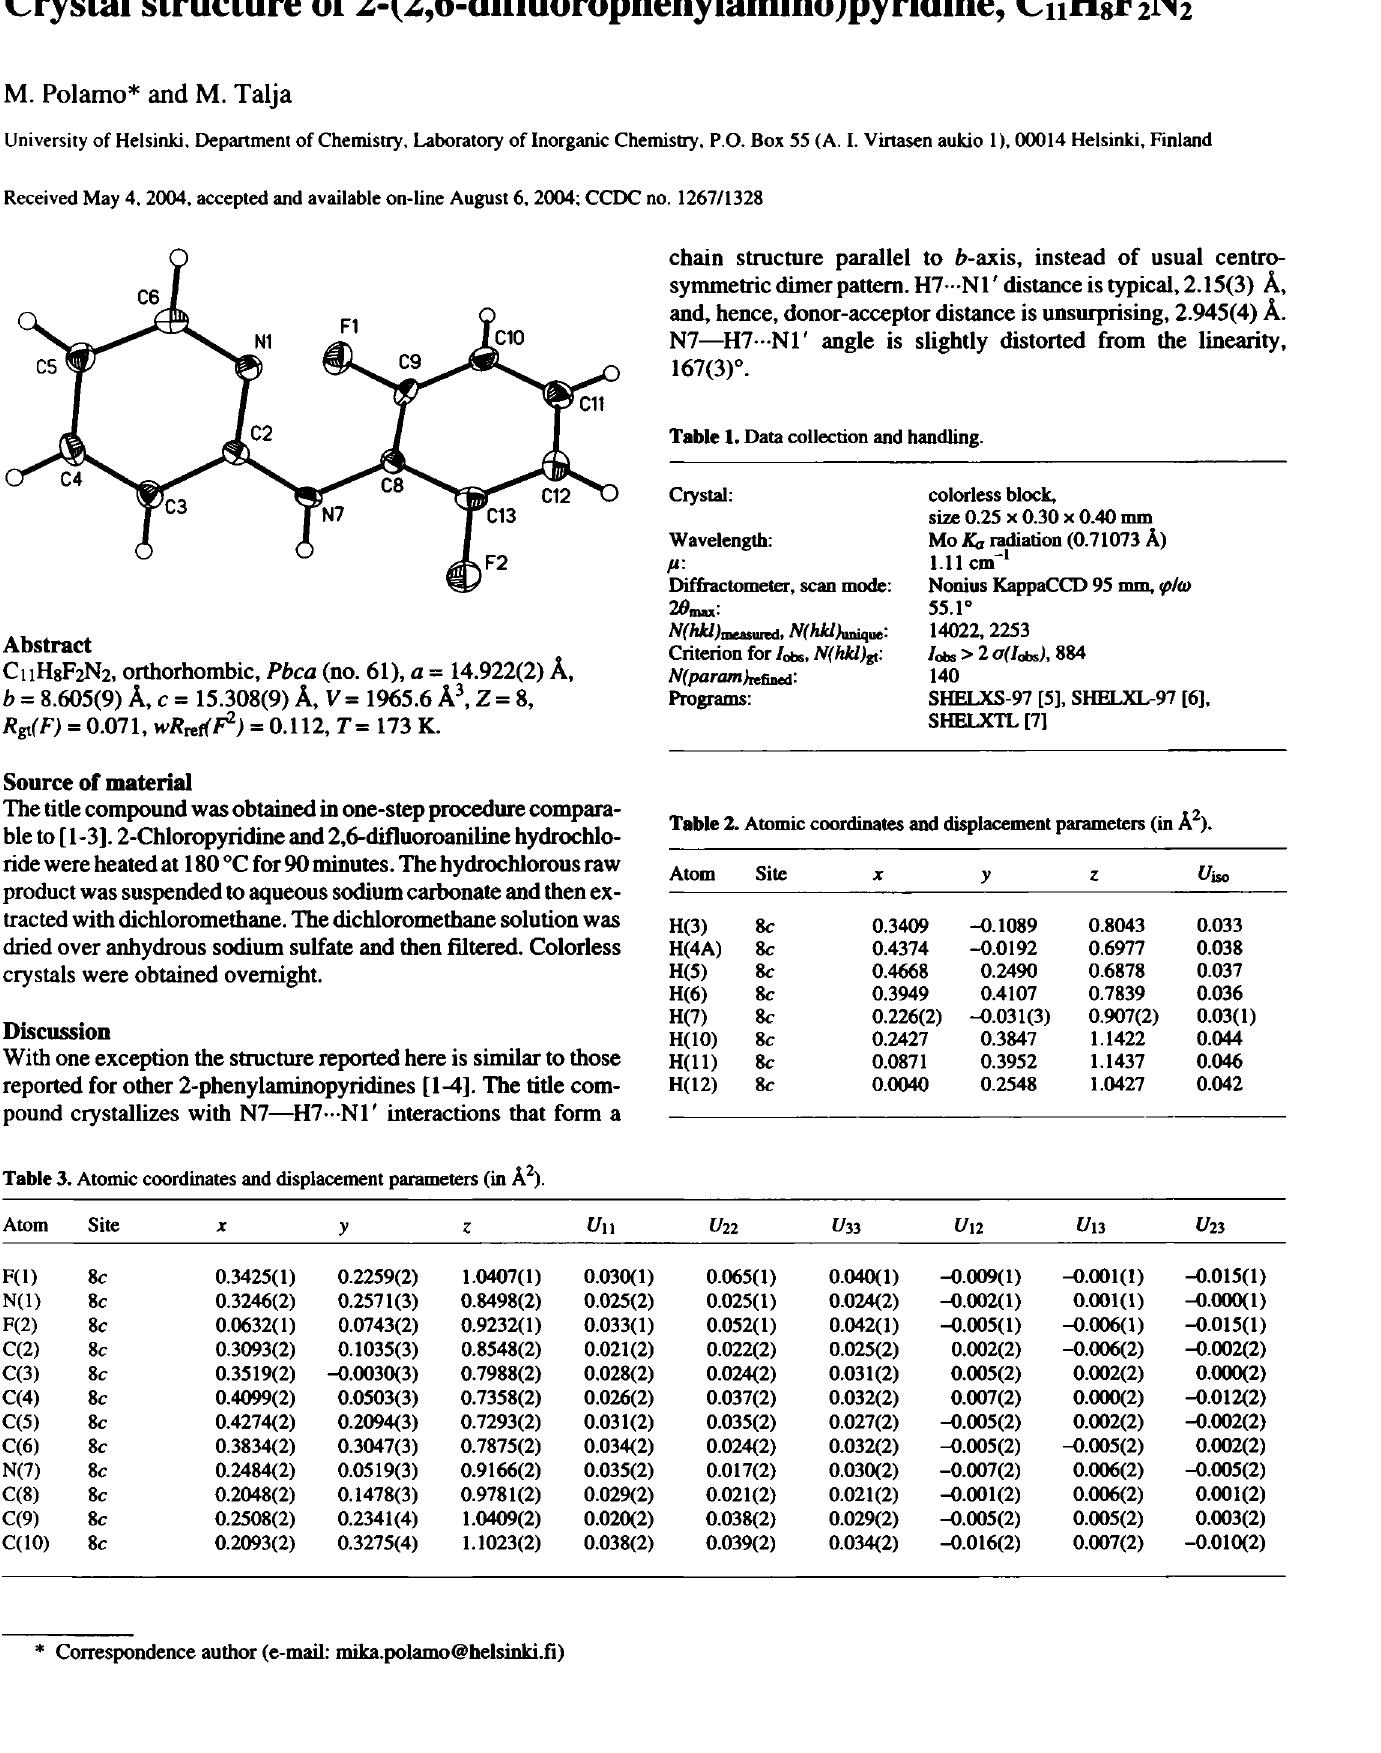
Table 3. Atomic coordinates and displacement parameters (in Â 2